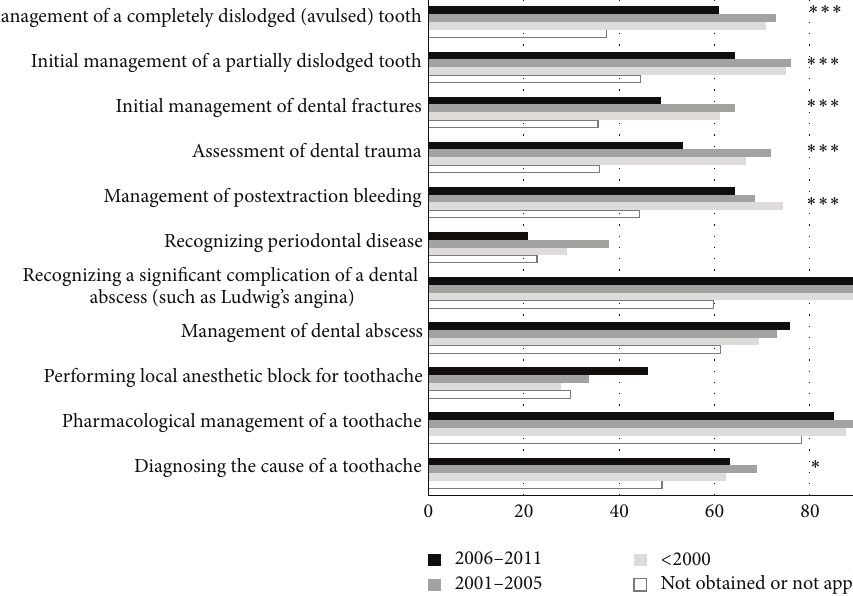
Figure 3: Practitioner confidence (agreed/strongly agreed) in specific skills relating to dental emergencies according to year the Fellowship was obtained. ∗ denotes 𝑃 < 0.05 . ∗∗∗ denotes 𝑃 < 0.001